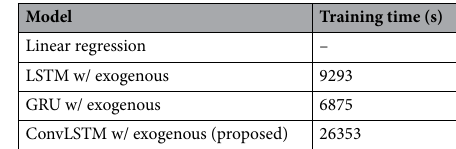
Table 8. Training time for each model.